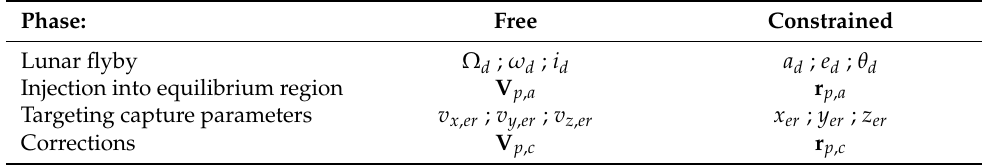
Table 1. Summary of free and constrained parameters during the different phases of the deployment.